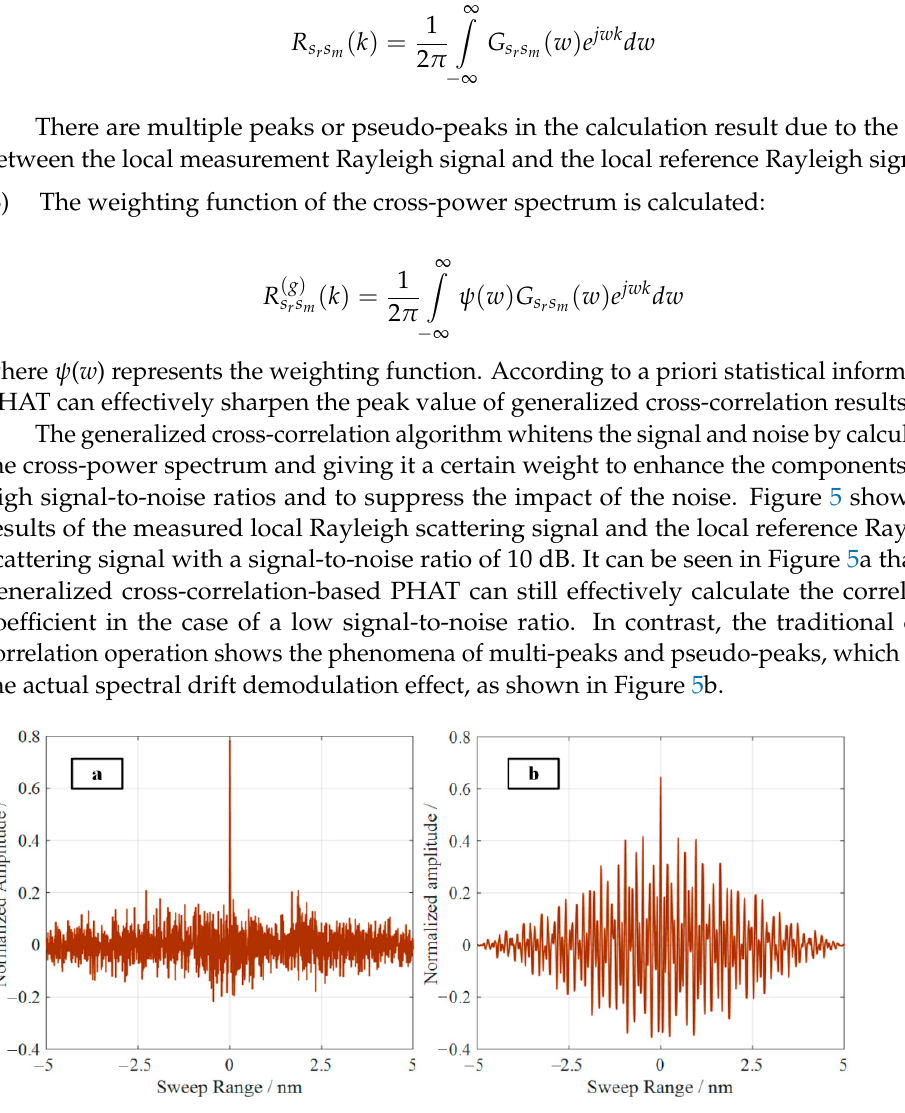
Figure 5. Results of traditional and generalized cross-correlation operations: ( a ) results of the generalized cross-correlation operation based on PHAT; ( b ) results of the traditional cross-correlation operation.